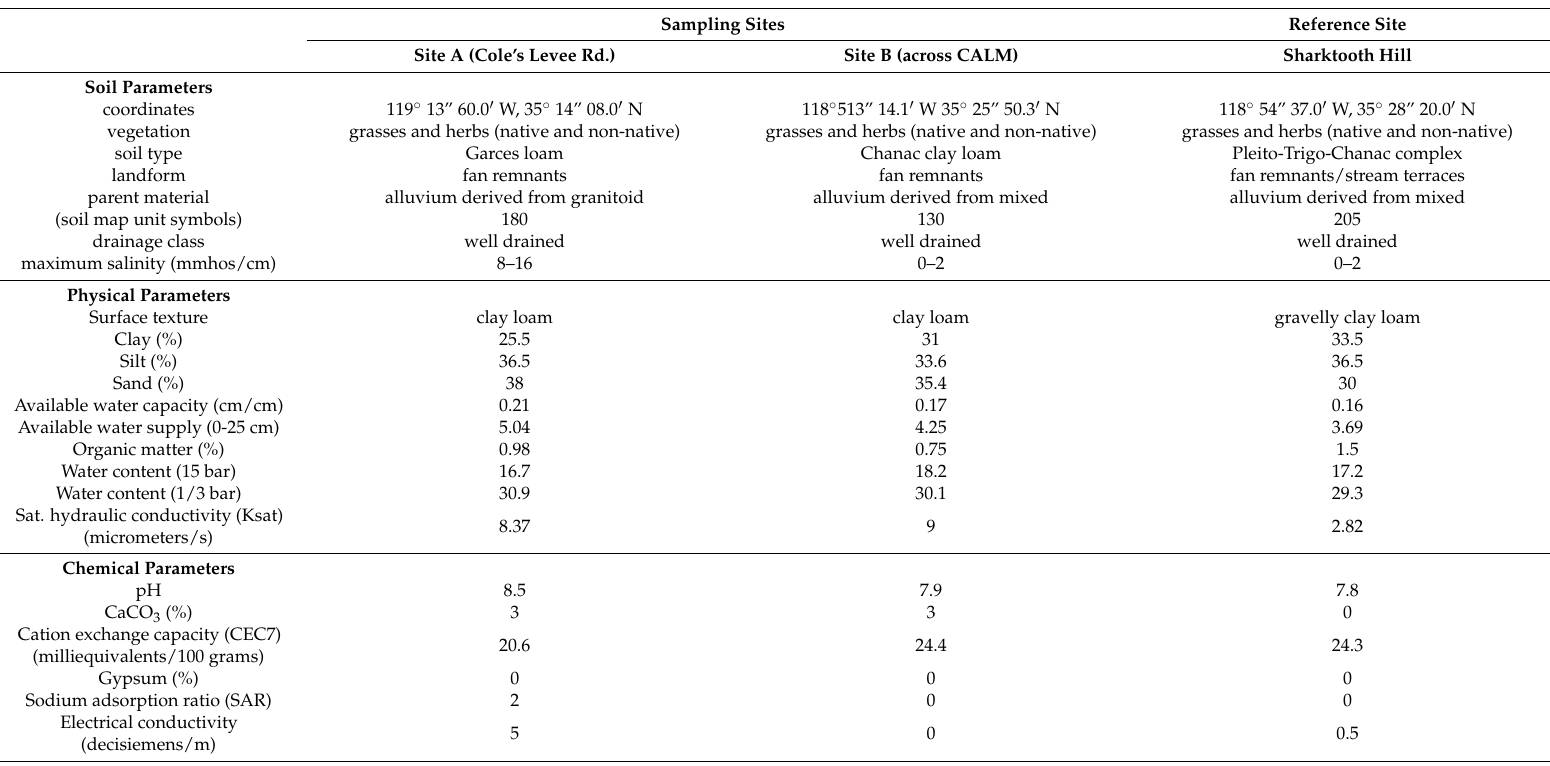
Table 1. Soil physical and chemical parameters obtained from the United States Department for Agriculture (USDA) websoilsurvey database for our two sampling sites and reference